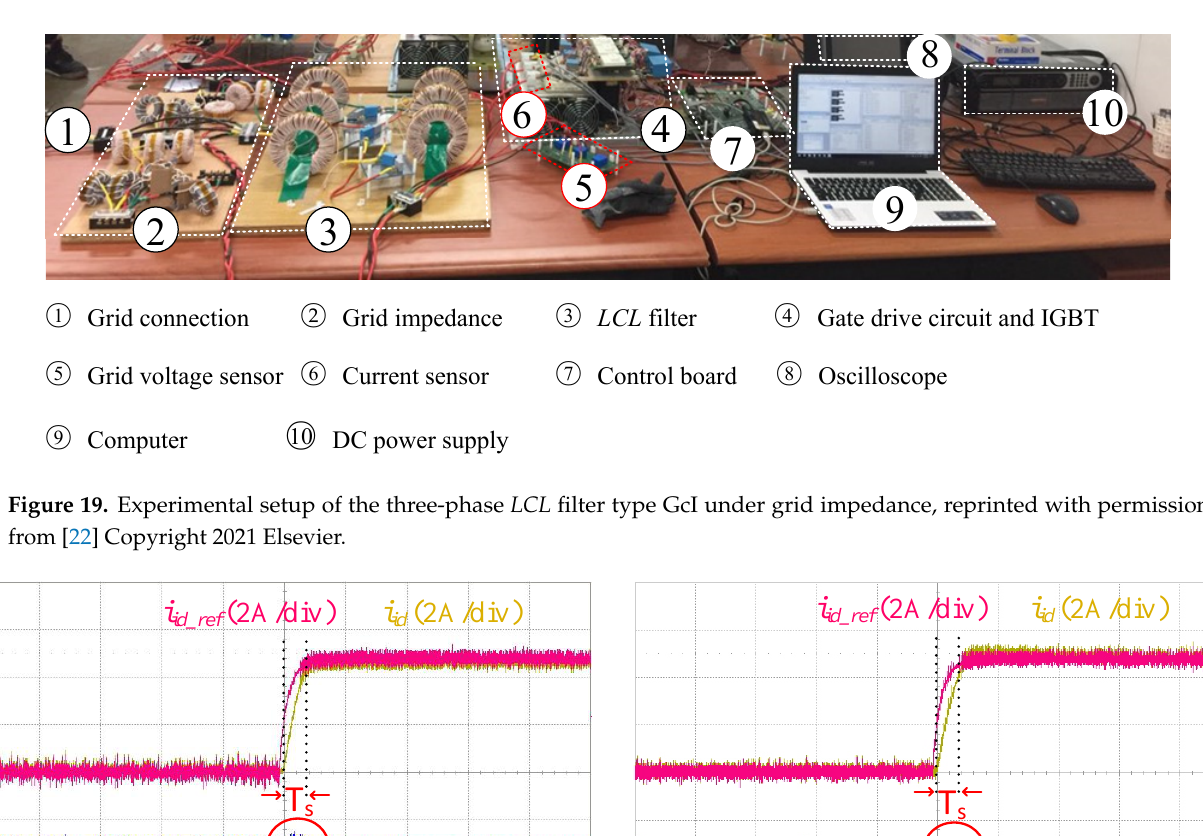
Figure 20. Current tracking i id and i iq for L filter type GcI with L grid = 0 ( a ) single-loop PI control; ( b ) RESO-based ADRC.